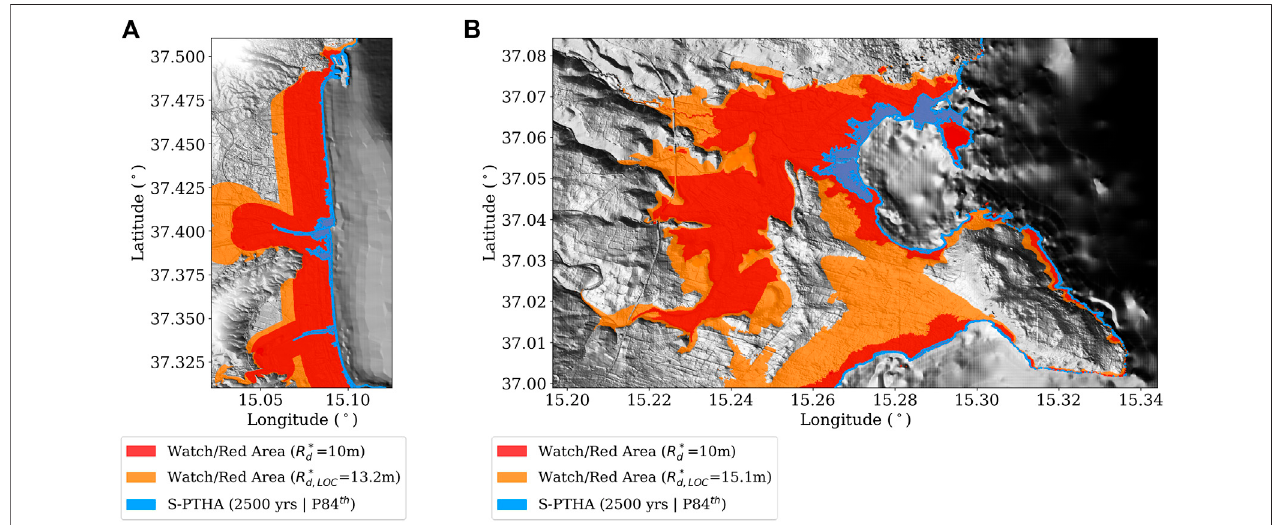
FIGURE 13 | For both Catania [panel (A) ] and Siracusa [panel (B) ], the watch/red alert areas designed using the values of R p d obtained from the local SPTHA increasedwiththe20%ofuncertainty(orangeareas)andthe R p